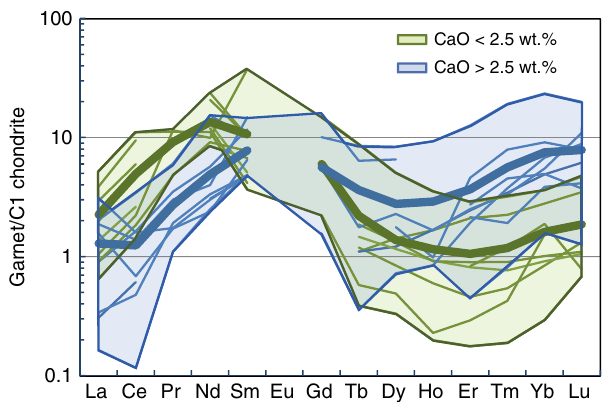
Fig. 3 Chondrite normalised rare earth element patterns of samples in the two age groups. Green lines indicate 3.0 Ga samples and blue lines 1.1 Ga samples. Thick lines represent group averages. The 3 Ga group samples have sinusoidal patterns with higher LREE but lower HREE compared with the 1.1 Ga group samples